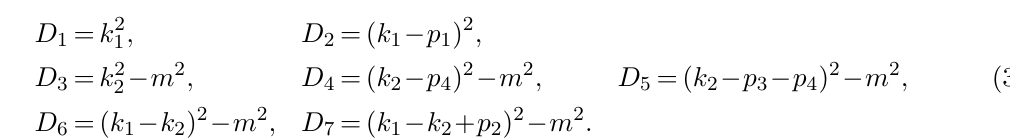
Table 4. Comparison between numerical results obtained with our algorithm from two di(cid:11)erential choices of initial conditions for the Feynman integral I 2 and I 3 at the point ( s = 5 ;t = and c 2 denotes the (cid:12)rst three coe(cid:14)cients in the Laurent series of (cid:15) . The results obtained from pySecDec [57] is also shown for consistency check and the corresponding setup is not